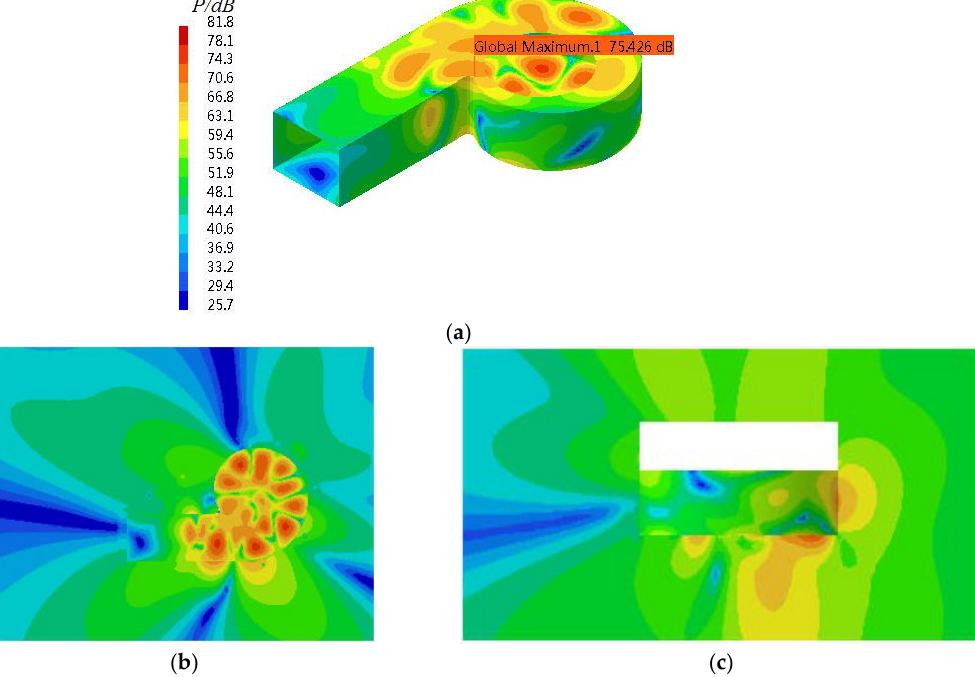
Figure 32. The radiated sound power distribution of the volute structure surface after multi-objective optimization. ( a ) The whole volute body; ( b ) XY section; ( c ) ZY section.